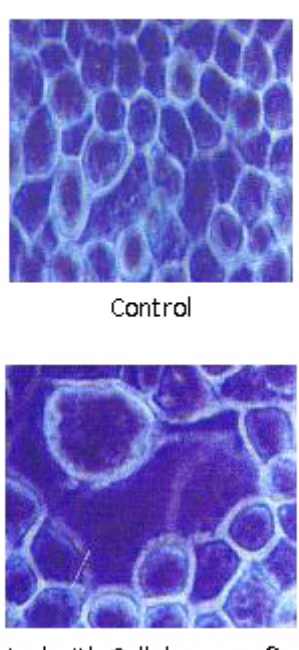
Figure 4. Growth inhibitory activity of Cellulomonas fimi bacterial crude extract from Arothron hispidus intestine against two cell